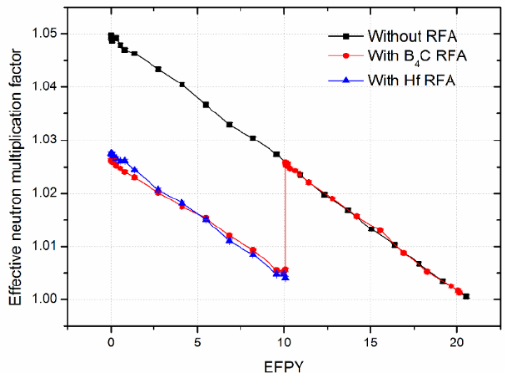
Figure 9. Depletion results for the MMR core with and without RFA material.